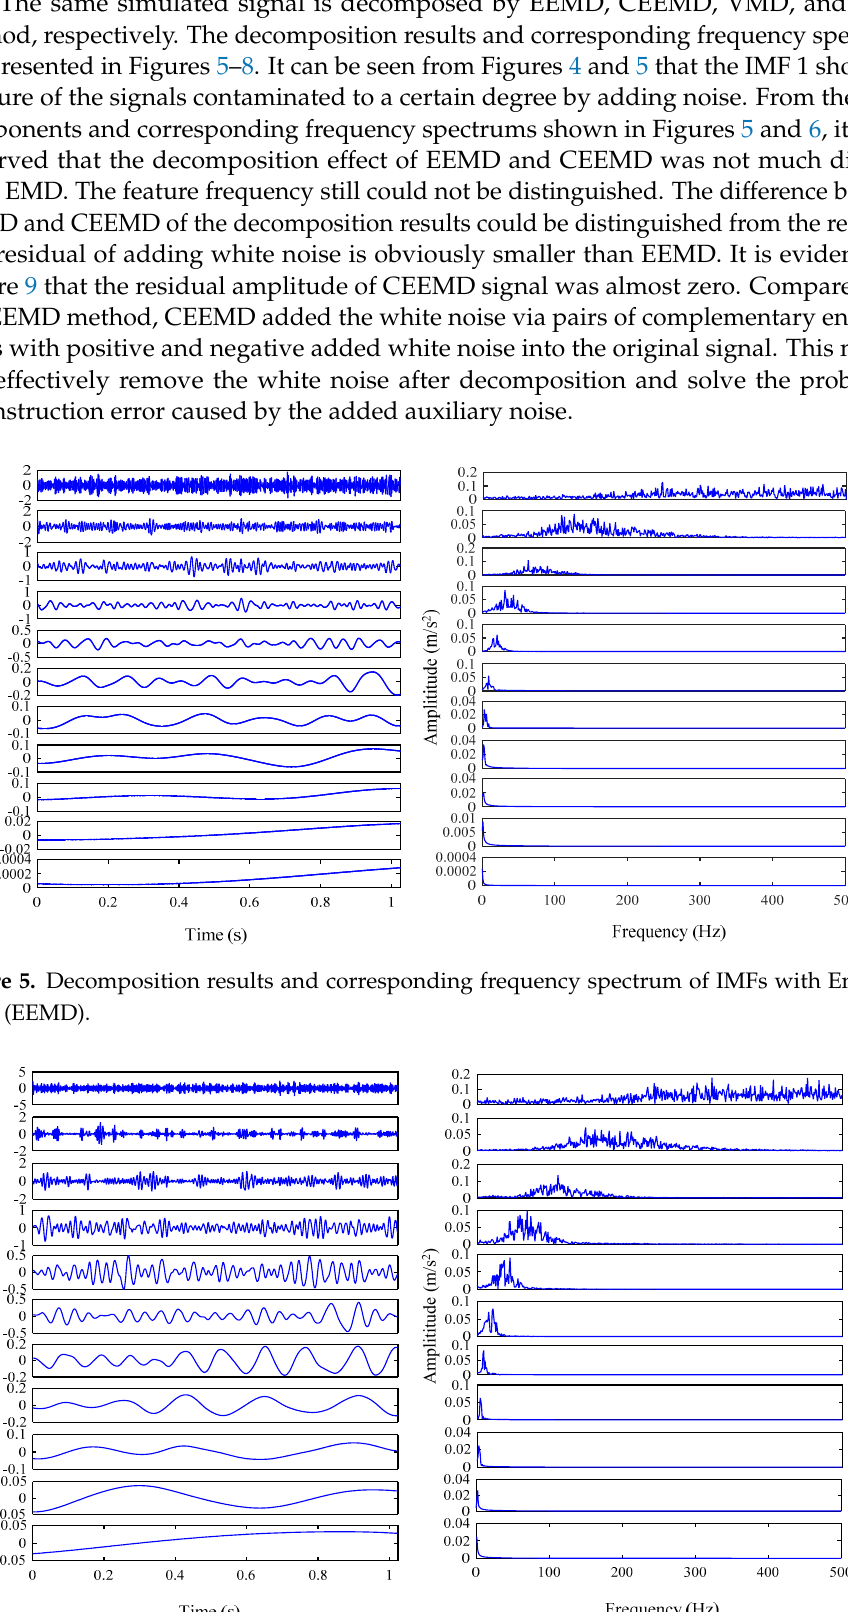
Figure 6. Decomposition results and corresponding frequency spectrum of IMFs with complementary ensemble empirical mode decomposition (CEEMD).